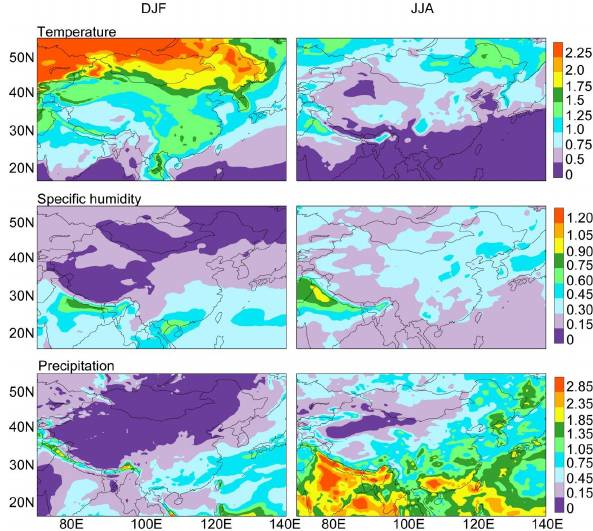
Figure 7. The MAD values of surface air temperature (K), spe- cific humidity (gkg − 1 ) and precipitation (mmd − 1 ) in DJF and JJA based on the GEOS-5 assimilated meteorological fields of 2004– 2012.